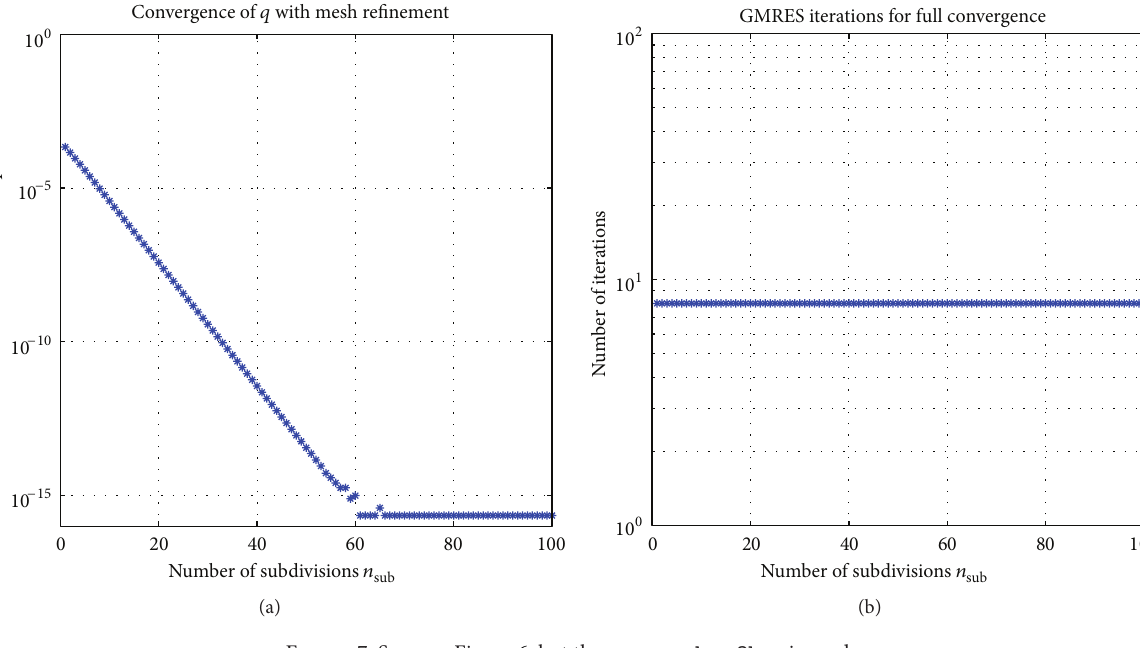
Figure 6: Same as Figure 3, but using (17) and the program demo2b.m (a loop of demo2.m ). There are only 𝑛 linear system.